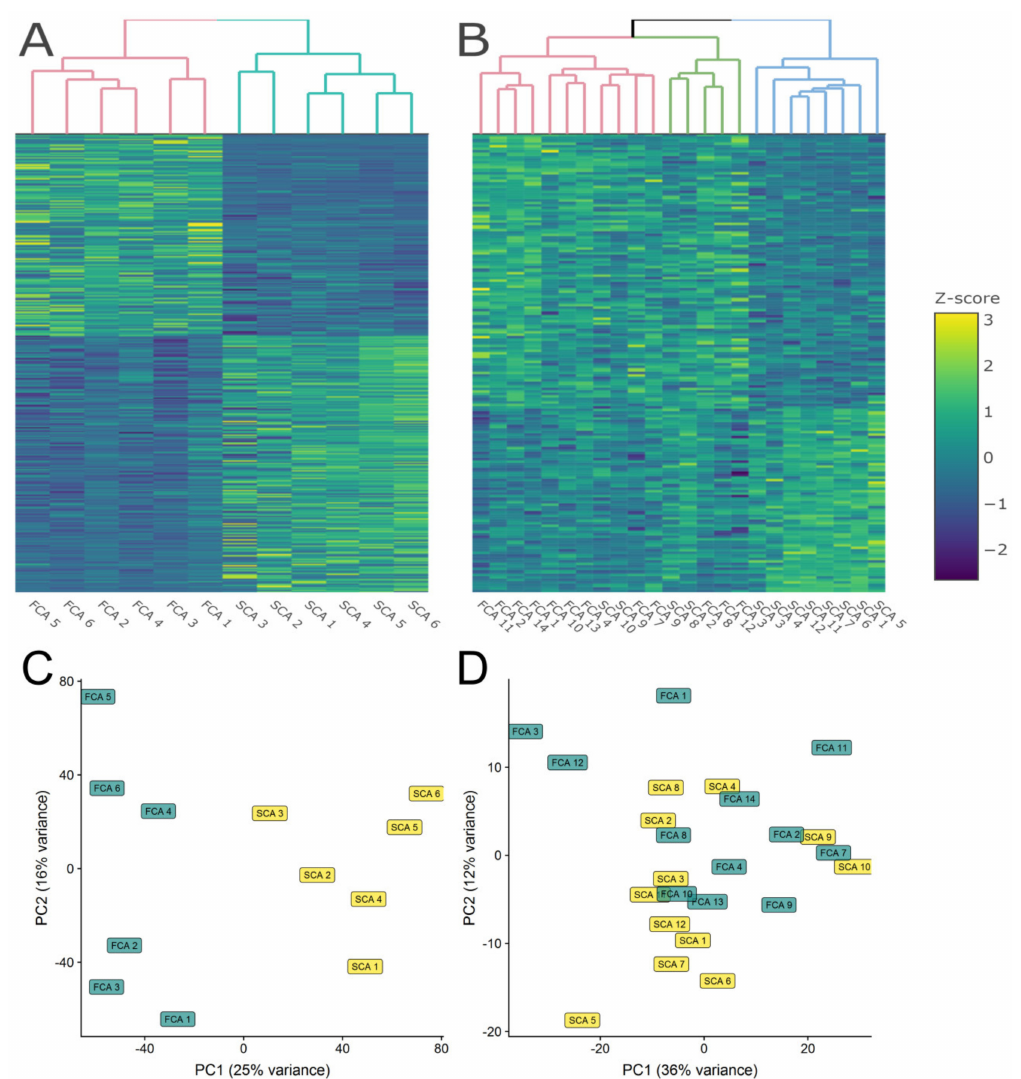
Figure 2. Heatmap ( A , B ) and principal component analysis (PCA; C , D ) profiling of RNA-seq di ff erentially expressed genes (DEGs; A , C ) and proteomic di ff erentially expressed proteins (DEPs; B , D ) in functioning (FCA) and silent (SCA) corticotroph